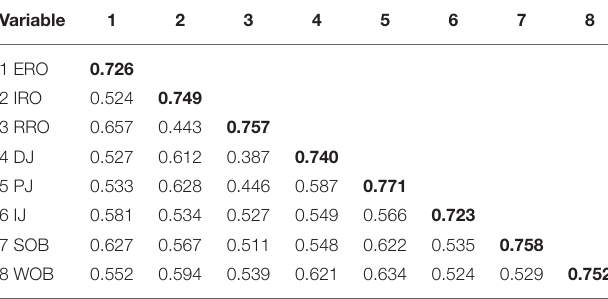
TABLE 4 | Discriminant validity analysis. Variable